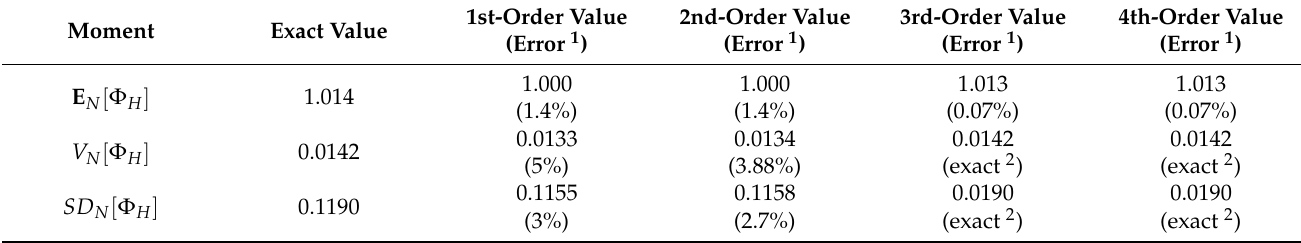
Table 1. Exact and approximate values for the expectation, variance and standard deviation of Φ H ( σ ; E ) for β = 0.2. Moment Exact Value